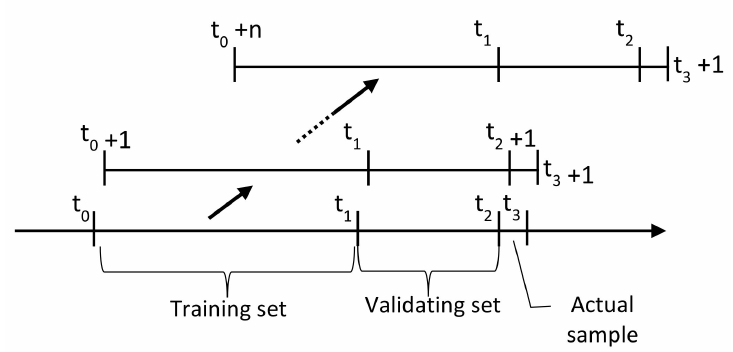
Figure 10. An anomaly detection algorithm based on SARIMA.